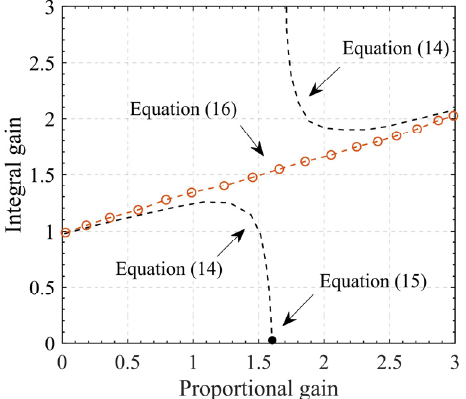
Figure 6. Stability boundary lines. The lower left side is the stability domain.